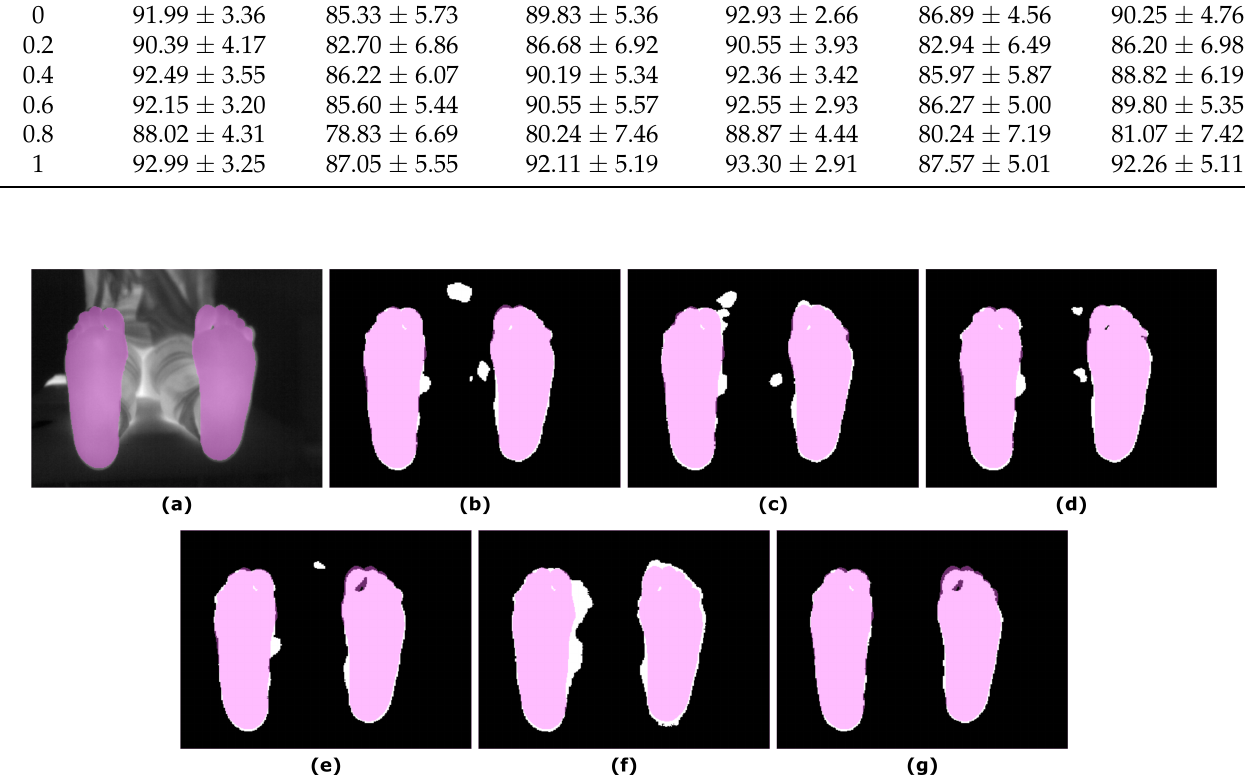
Figure 4. Illustrative example showing the final prediction for the SegNet approach according to the α parameter in Equation (1): ( a ) IR input image; ( b ) Final prediction α = 0; ( c ) Final prediction α = 0.2; ( d ) Final prediction α = 0.4; ( e ) Final prediction α = 0.6; ( f ) Final prediction α = 0.8; ( g ) Final prediction α = 1. The ground truth (pink mask) was overlapped to both, the IR image and the corresponding final predictions (white